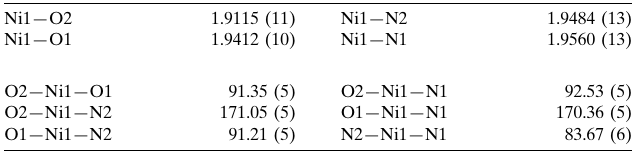
Selected geometric parameters (A˚ , (cid:1)